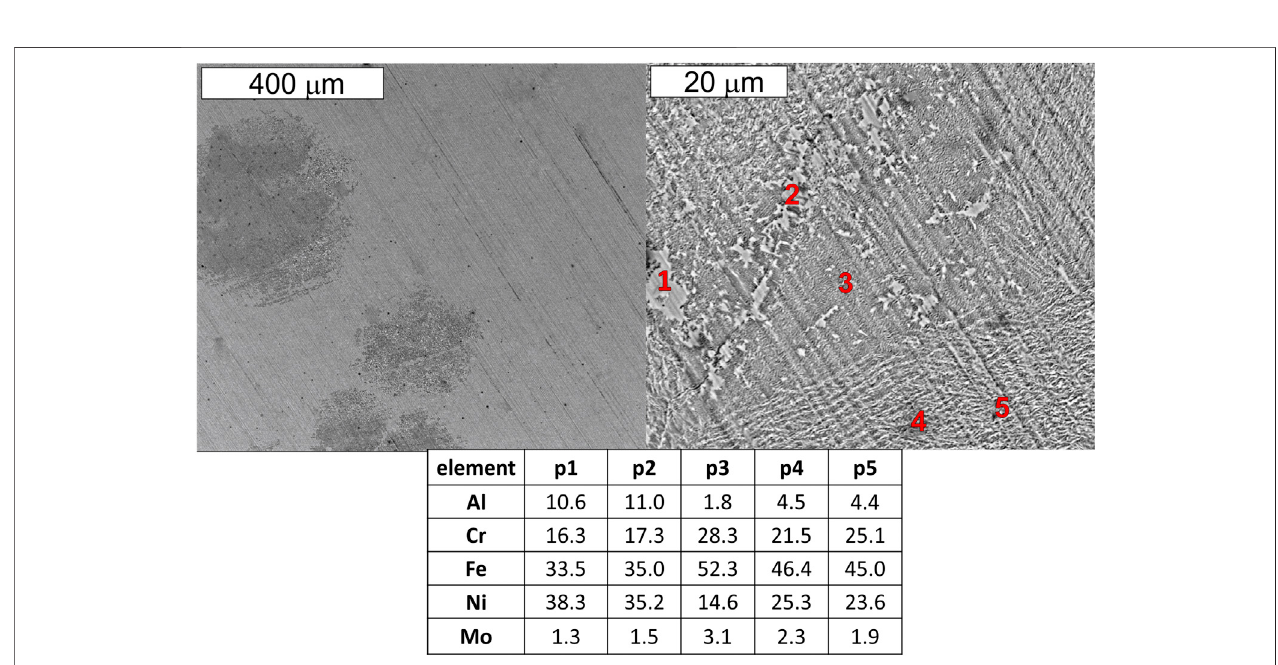
FIGURE 9 | Surface of an AlCrFe 2 Ni 2 Mo 0.10 sample after potentiodynamic polarization test (Tafel) in 3.5 wt% NaCl and EDS analysis (at.%) in marked points.